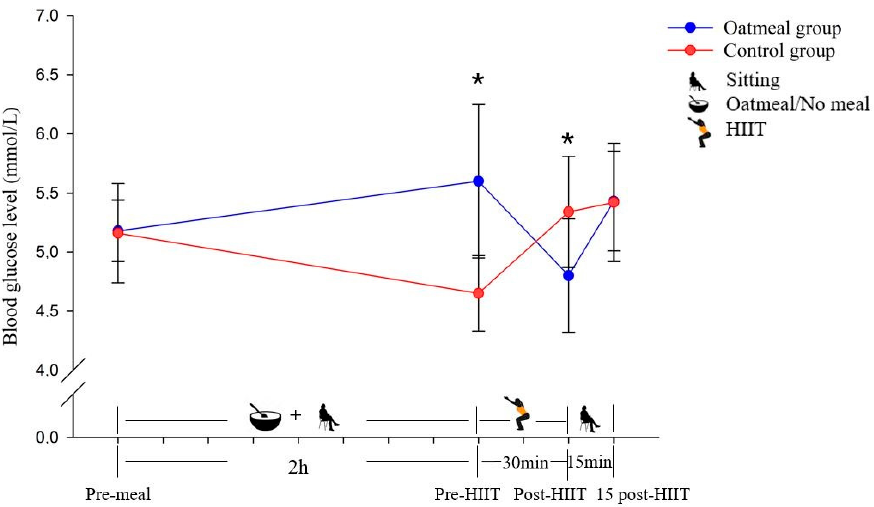
Figure 2. Changes of the reactive oxygen species (ROS) generation in µ M/min (mean ± SD) from pre-meal to 15 post-HIIT in the two groups (* p < 0.05; a significant difference between the oatmeal group and control group was detected by an independent t -test).